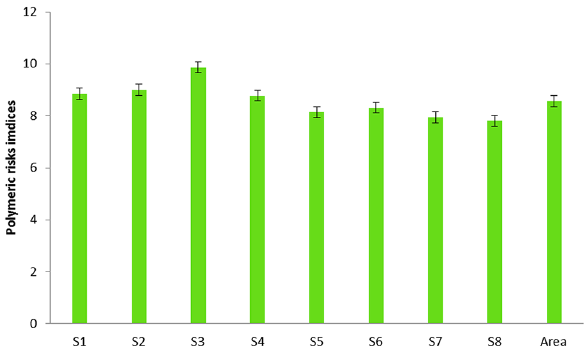
Figure 9. Polymeric risk indices for MP types in salts from stations S1 to